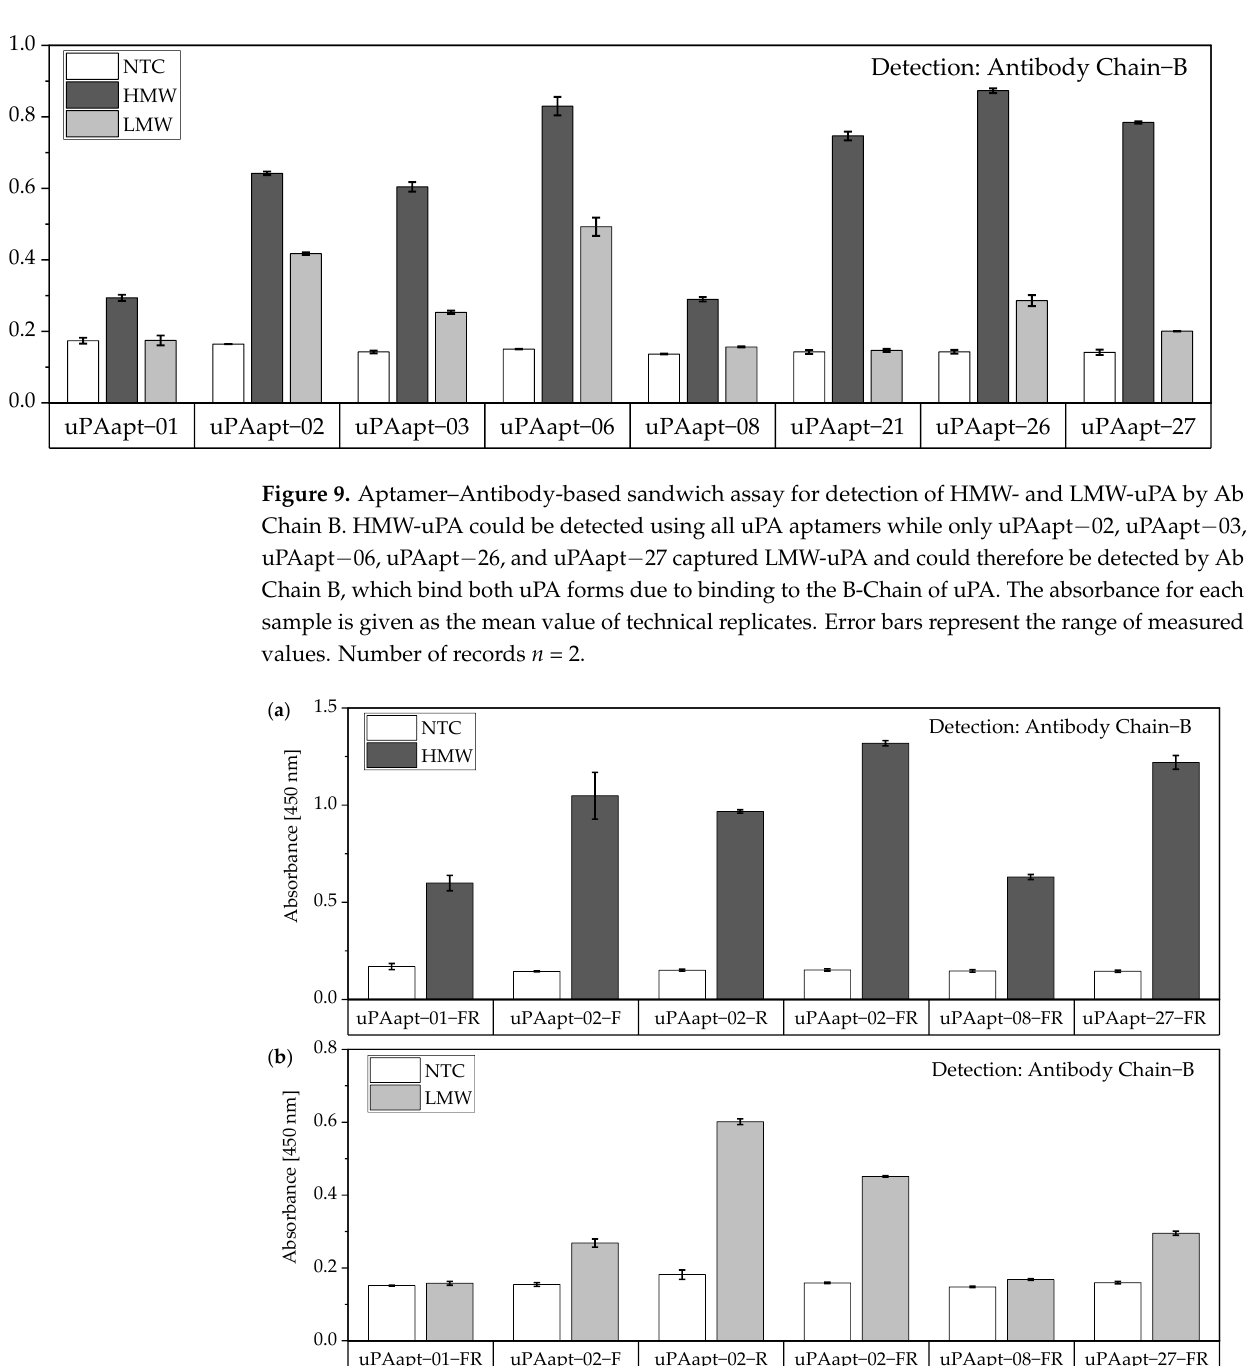
Figure 10. Aptamer–Antibody-based sandwich assay for detection of ( a ) HMW- and ( b ) LMW-uPA by Ab Chain B. HMW-uPA could be detected using all truncated uPA aptamers while only uPAapt − 02 − F, uPAapt − 02 − R, uPAapt − 02 − FR, and uPAapt − 27 − FR captured LMW-uPA and could therefore be detected by Ab Chain B, which bind both uPA forms due to binding to the B-Chain of uPA. The absorbance for each sample is given as the mean value of technical replicates. Error bars represent the range of measured values. Number of records n =